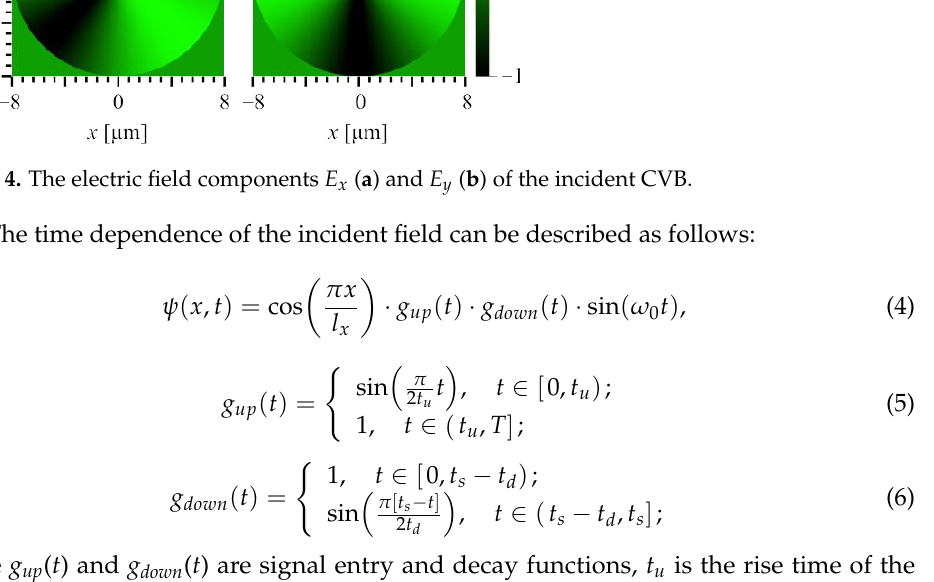
Figure 4. The electric field components E x ( a ) and E y ( b ) of the incident CVB.